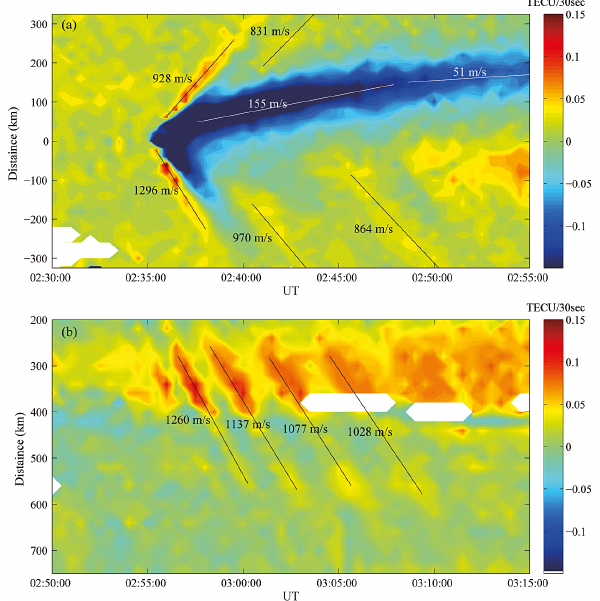
Figure 4. The rTEC time–distance velocity diagram (a) calcu- lated from the center of the rectangle indicated in Fig. 1a (pos- itive distance indicates northward propagation) from 02:30:00– 02:55:00UT (11:30:00–11:55:00LT) for the 2009 NK event; (b) ve- locity diagram of delayed waves along the bow wave direction calculated from the upper short side of the rectangle indicated in Fig. 1e (positive distance indicates southeastward propagation).